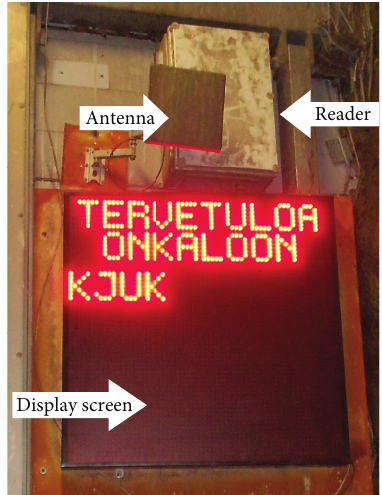
Figure 5: An ONKALO reading point and display screen.